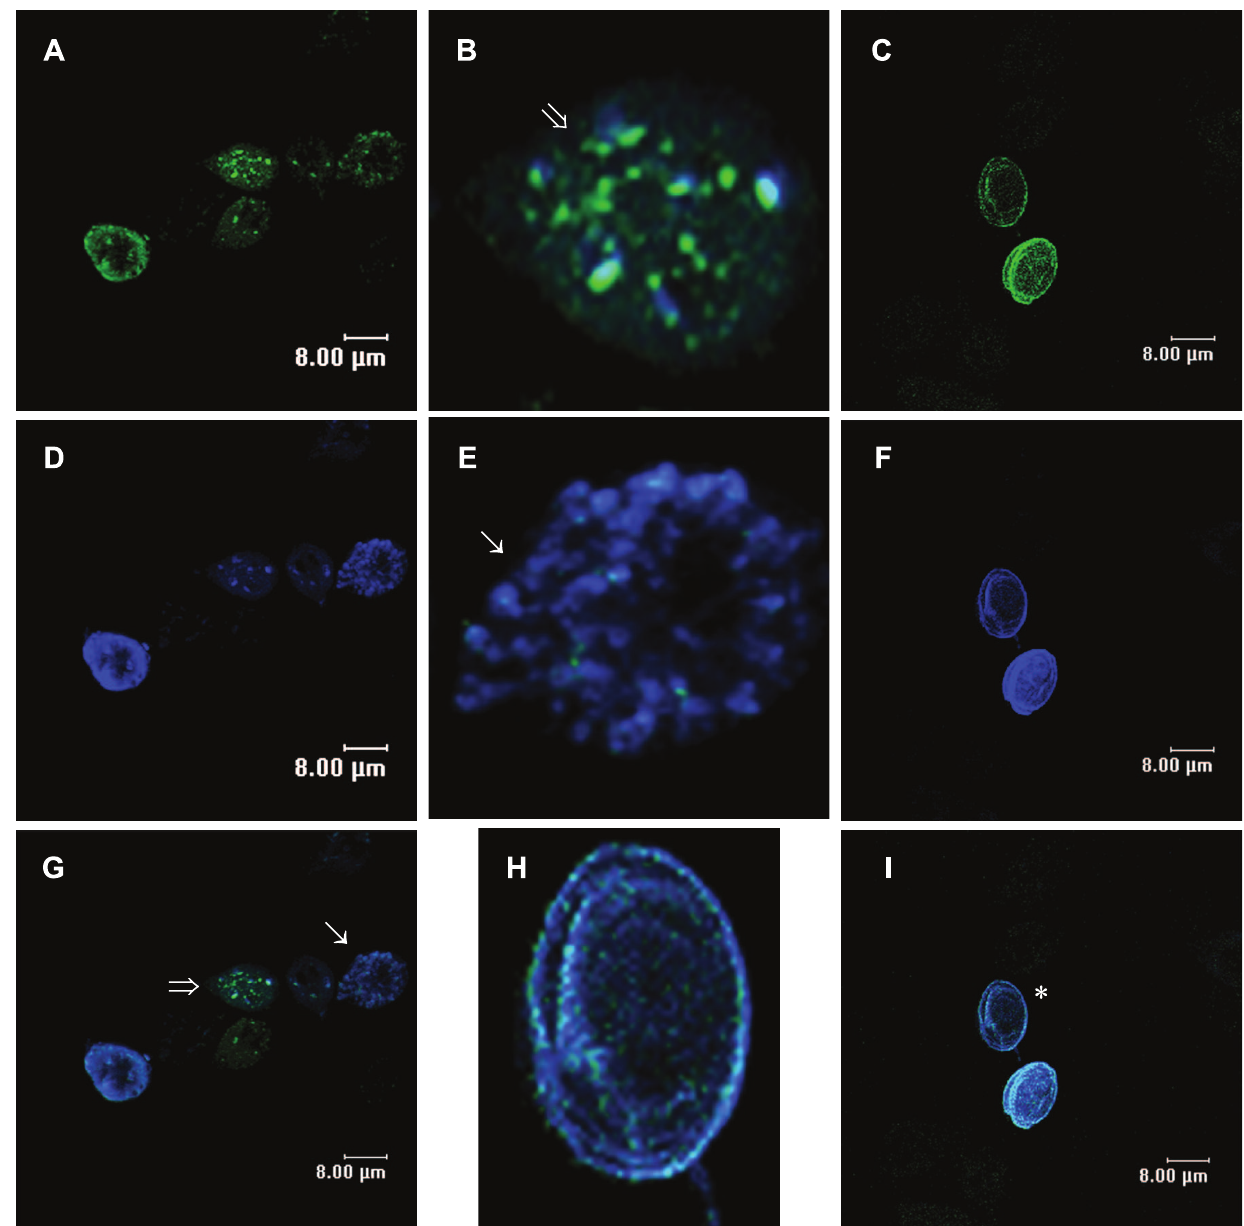
Figure 5. Rab11 colocalizes with CWP1 and translocates to the cyst’s periphery during Giardialamblia encystation. Parasites of the different cell populations induced to undergo encystation were stained with the anti-Rab11 antibody and a FITC-conjugated goat-anti rat secondary antibody ( A and C ) or with the anti-CWP1 antibody and a Cy5-conjugated goat-anti mouse secondary antibody ( D and F ). G and I are the merged images showing both Rab11 and CWP1 staining. A and D show precyst. C and F show cysts. B , E and H are magnified images of precysts and cysts. Arrows and the asterisk indicate the magnified cells.